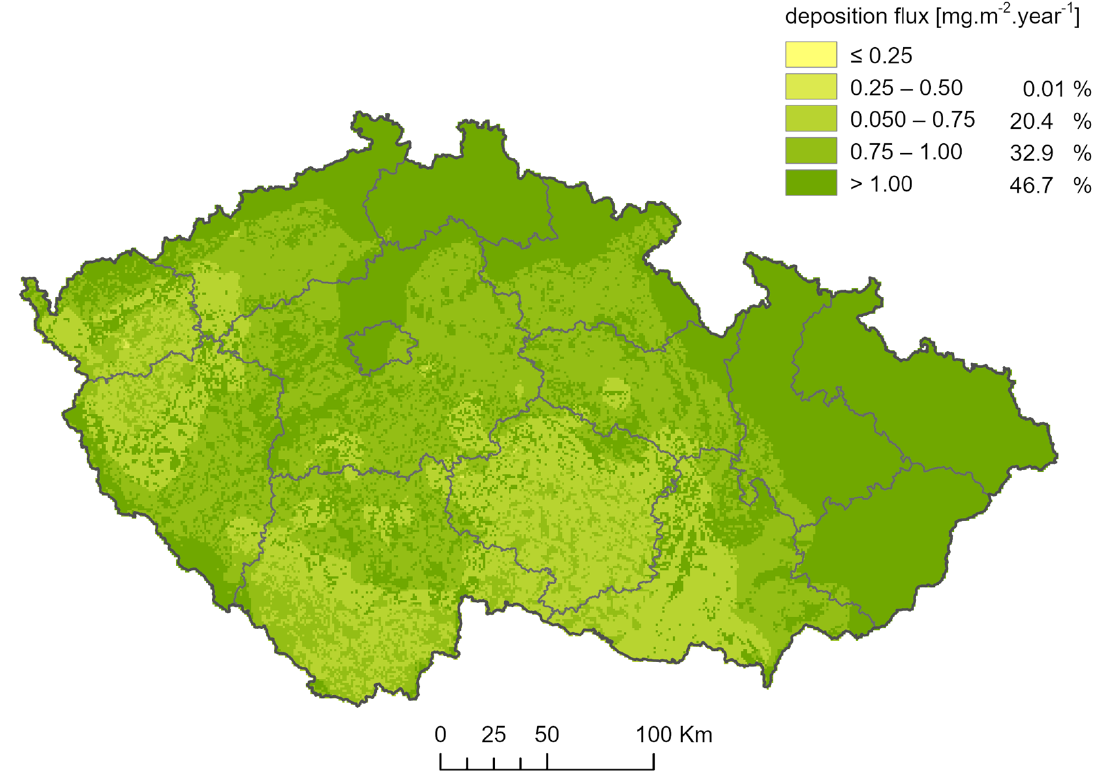
Figure 5. Spatial pattern of total Pb deposition, 2012.